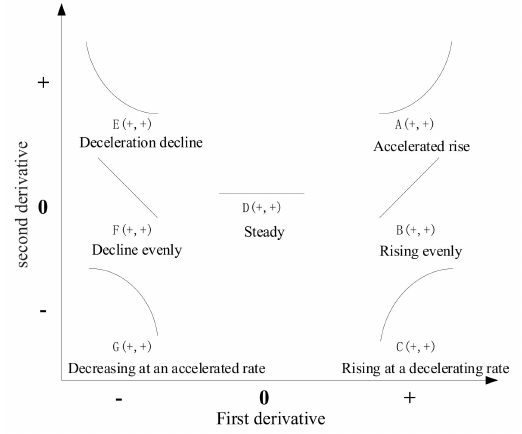
Figure 3. Primitives of the trend.